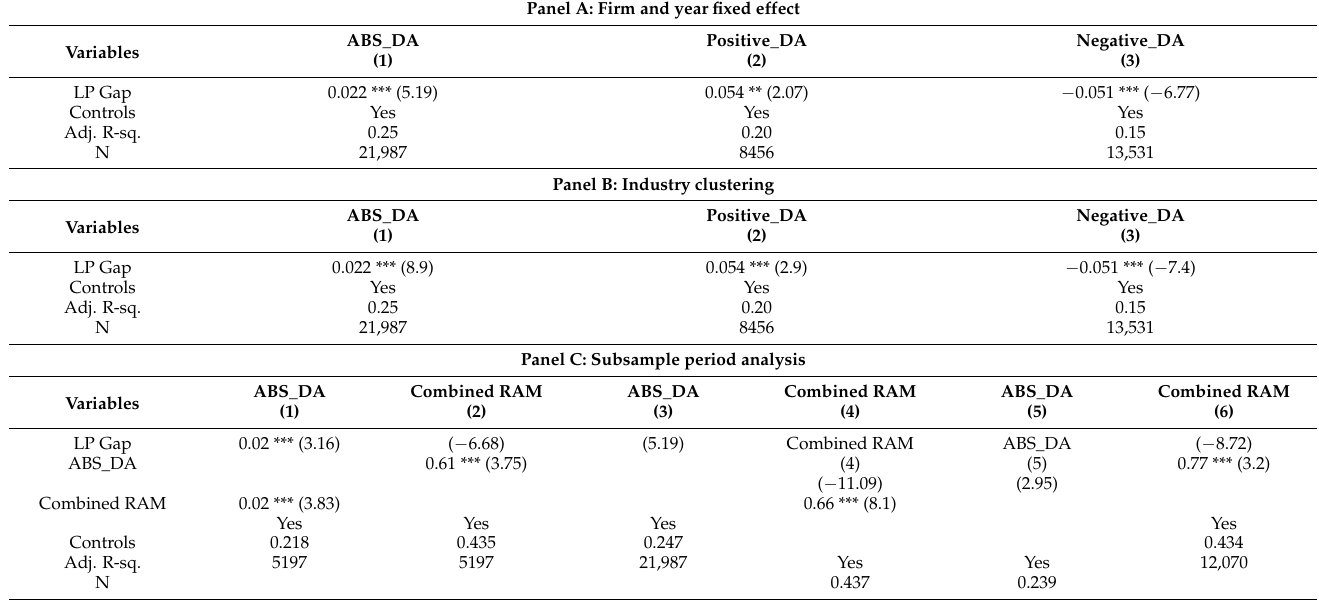
Table 8. A . Robustness checks for Firm and year fixed effects. B . Robustness checks for Industry clustering. C . Robustness Check for Subsample period analysis. (** indicates level of significance at 95% level and *** indicates level of significance at 99% level).